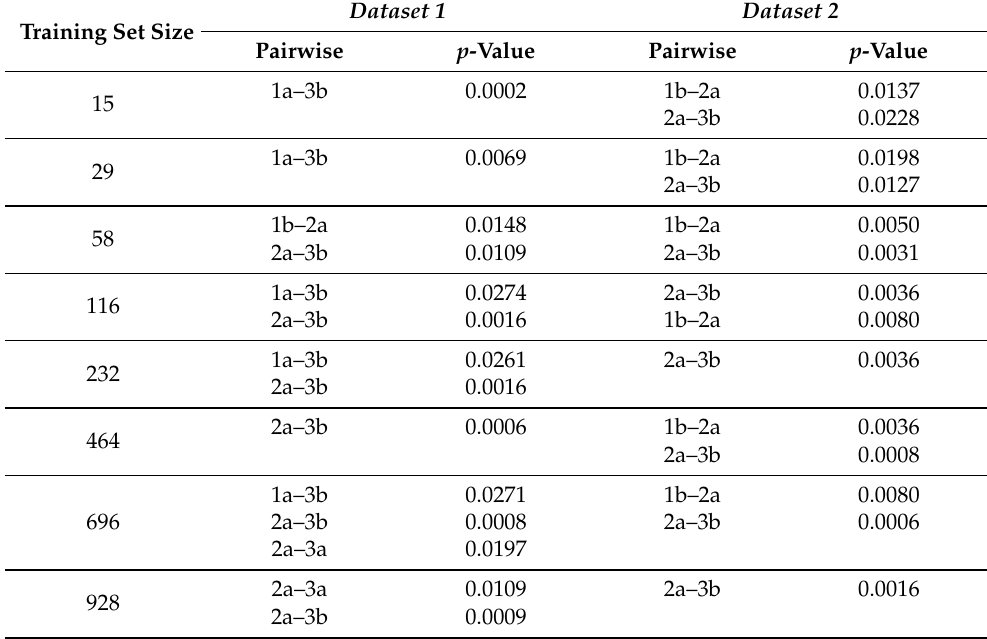
Table 1. Statistically significant differences of Comparison